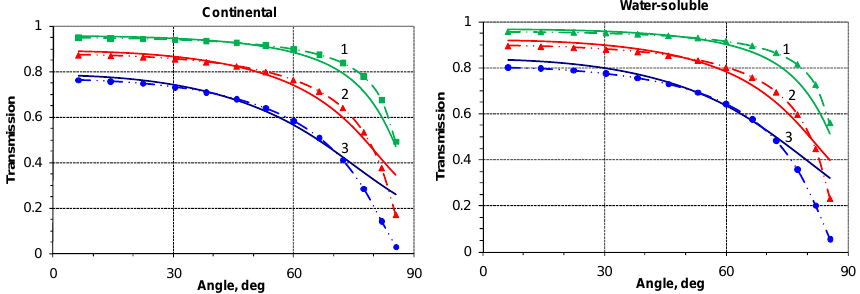
Fig. 7. The transmission coefficient t 1 (µ 0 ) versus the Sun zenith angle ϑ 0 = arccos µ 0 at τ 1 = 0 . 2 (1), 0.5 (2) and 1 (3) for the Continental and Water-soluble aerosols. Computations with RAY (solid lines) and with Eq. (23) (signs) are shown.